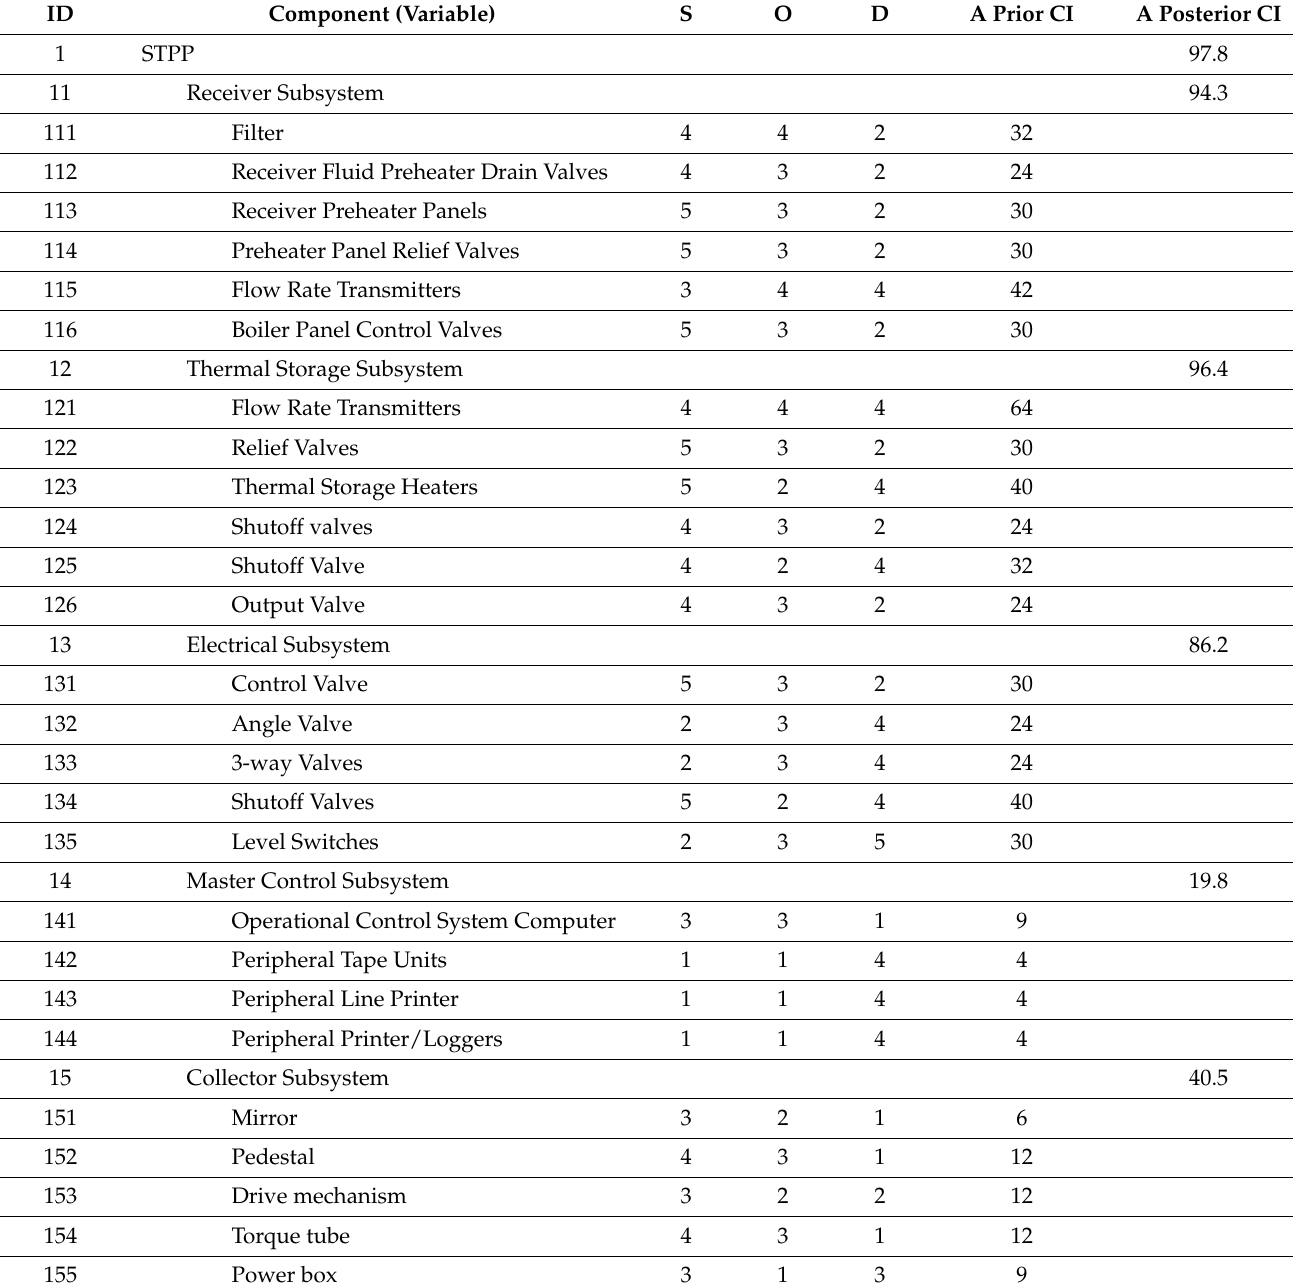
Table 8. Identification of variables and criticality assessment of